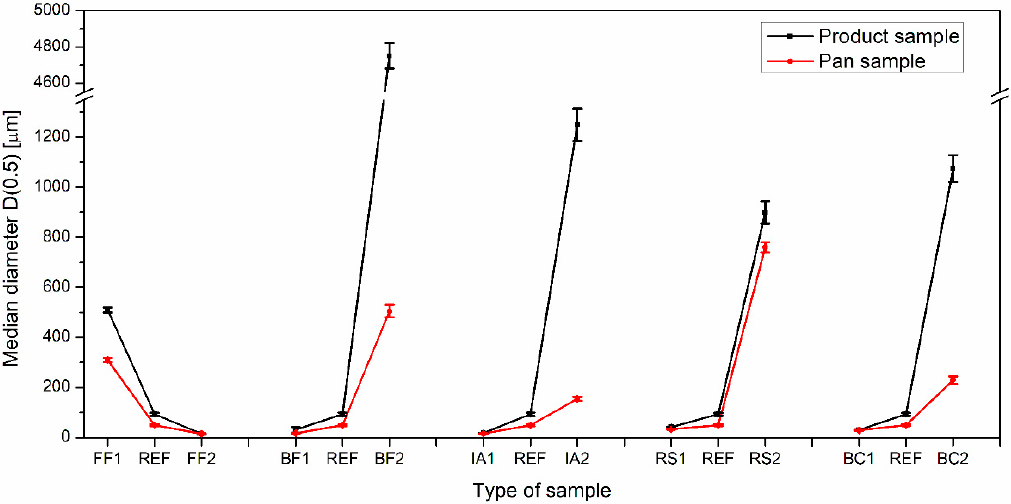
Figure 11. Influence of the operating parameters on the D(0.5) diameter.